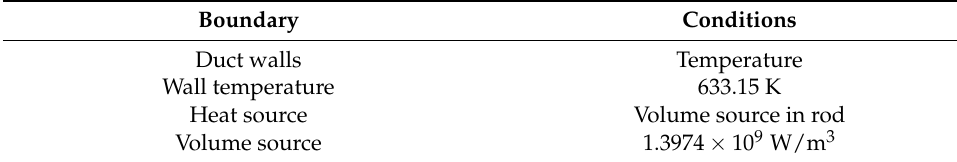
Figure 13. Shape and material of the solid model. Table 4. Boundary conditions.